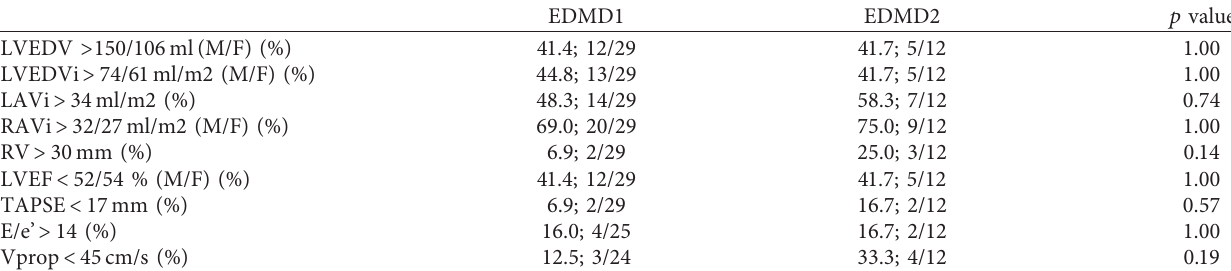
Table 4: Percentage of EDMD patients meeting the following criteria.